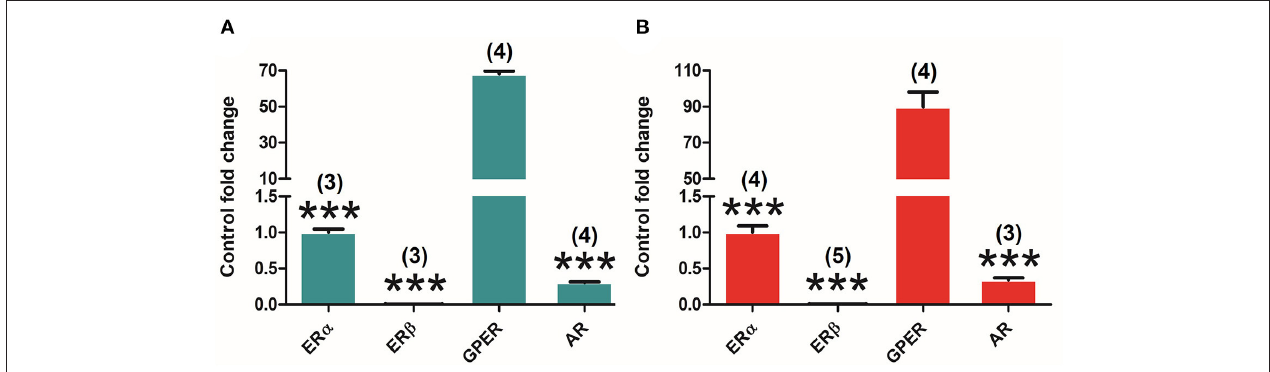
FIGURE 5 | Differential ER and AR expression in the adrenal gland of adult male and female rats. (A) ER α ( n = 3), ER β ( n = 3), GPER ( n = 4), and AR ( n = 4) expression levels in male animals. (B) ER α ( n = 4), ER β ( n = 5), GPER ( n = 4), and AR ( n = 3) expression levels in female animals. Data are represented as mean ± SEM. ***Significant differences (*** p < 0.001) vs. GPER values.